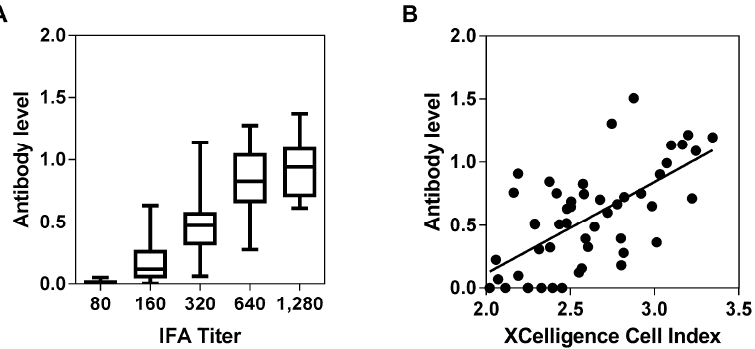
Figure 2. Comparison of ELISA (enzyme linked immunosorbent assay results) (antibody level) and IFA (immunofluorescence assay) titer ( A ) or neutralization assay (( B ) XCelligence Cell Index) for a panel of sera (( A ) n = 100; ( B ) n = 50) collected from German blood donors.